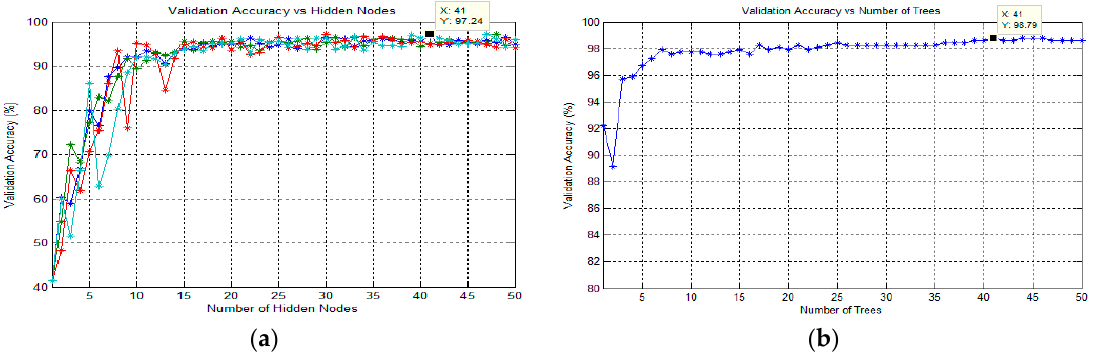
Figure 12. Analysis for classifications of P. falciparum species into their four life-cycle stages: ring, mature trophozoite, schizont, and gametocyte stages: ( a ) OS-ELM; ( b ) Random forest.